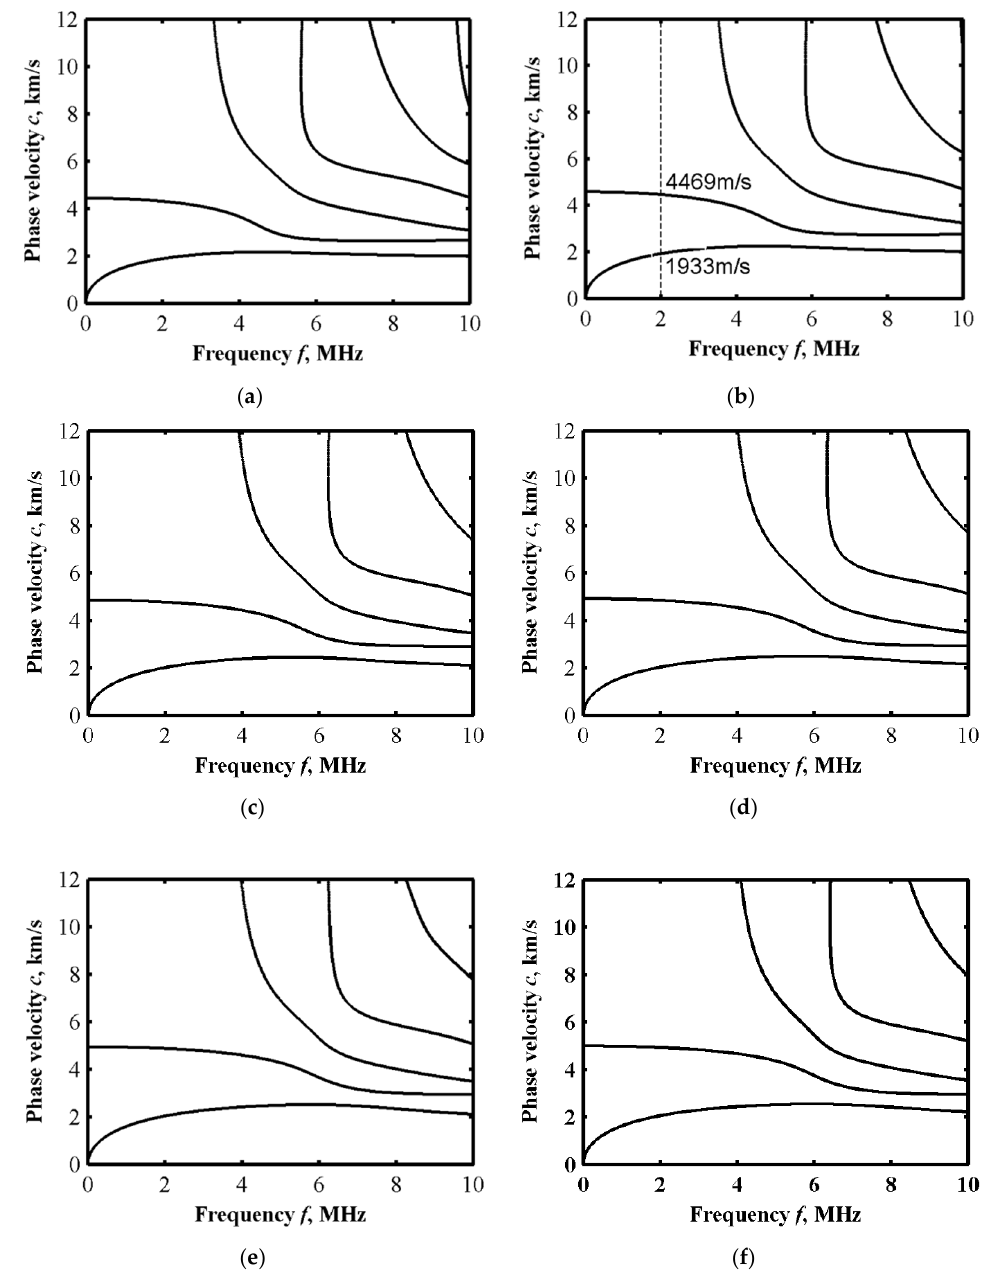
Figure 5. Lamb wave dispersion curve in FGM sandwich plates. ( a ) n = 0.5; ( b ) n = 1; ( c ) n = 5; ( d ) n = 10; ( e ) n = 20; ( f ) double-layered plate with 0.1 mm Cu and 0.3 mm steel.